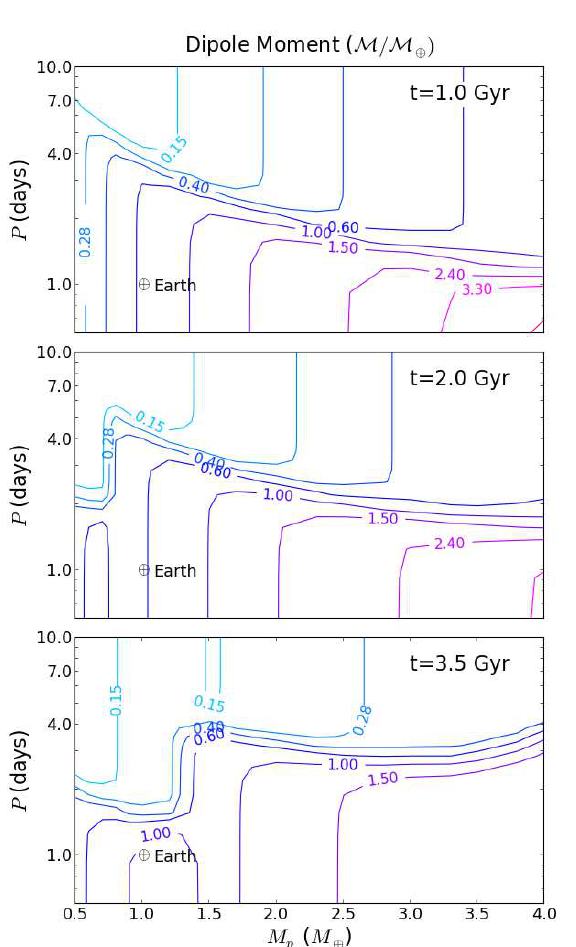
Figure 16. Mass-Period (M-P) diagrams of the dipole moment for long-lived planetary dynamos computed using RTE. Three regimes are identified [ZU12]: rapid rotating planets ( P ∼ 1 day) whose dipole moment are large and almost independent of rotation rate; slowly rotating planets (1 < P < 5 days), whose dipole moment are intermediate in value and highly depend of rotation rate; and very slowly rotating planets ( P > 5 − 10 days) with small but non- negligible rotation-independent dipole moments. At lower masses ( M < 2 M ) the shape of the dipole-moment contours is deter- ⊕ p mined by the time of inner-core formation: ~1 Gyr for 0.5 M , ~2 Gyr ⊕ for 1.0 M and (cid:38) 4.6 Gyr for M (cid:38) 1.5 M . (Figure from ZU13, with ⊕ ⊕ p permission of the